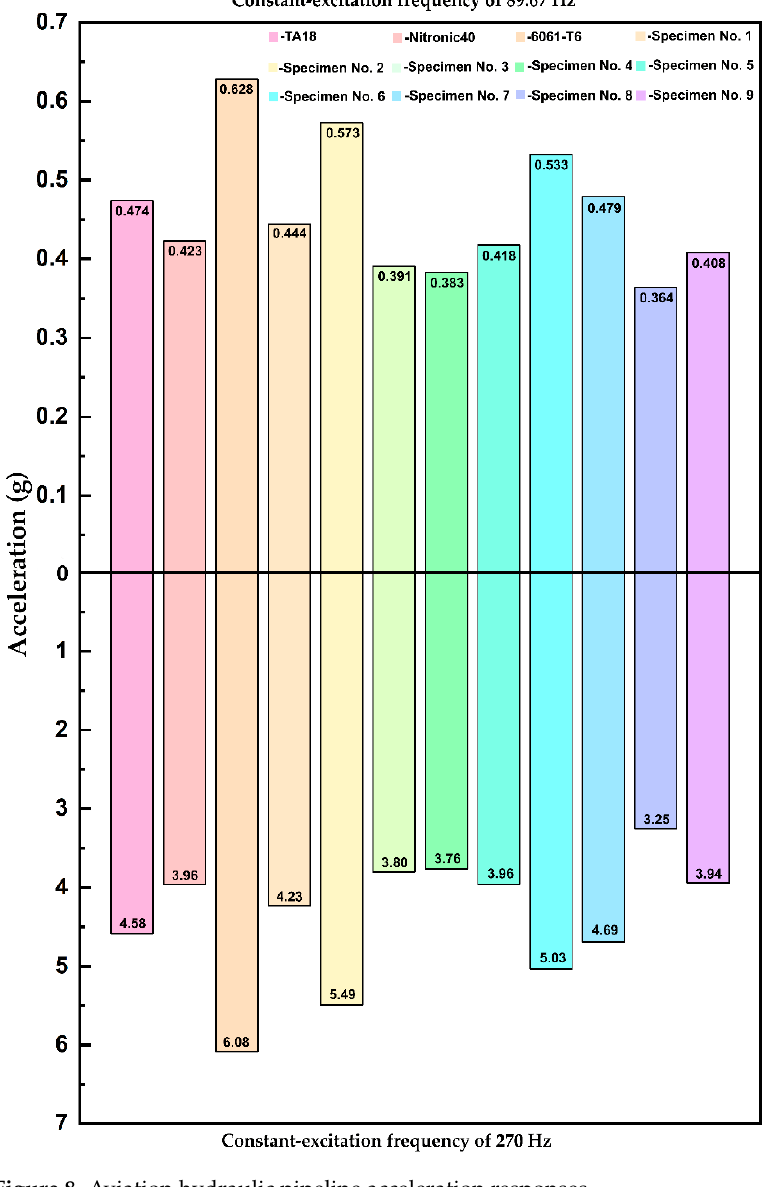
Figure 8. Aviation hydraulic pipeline acceleration responses. Table 10. Fixed-frequency excitation vibration response